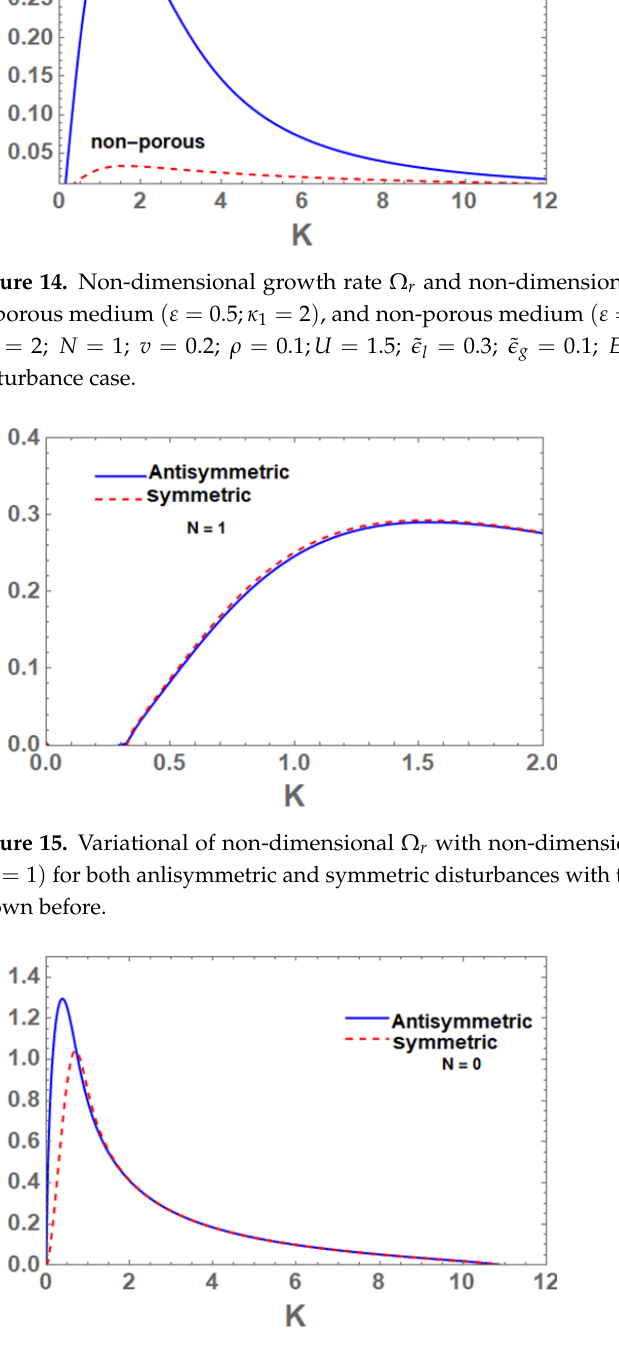
Figure 16. Change in in non-dimensional Ω r with non-dimensional K in two-dimensional case ( N = 0 ) for both antisymmetric and symmetric disturbances with the same values of the parameters used